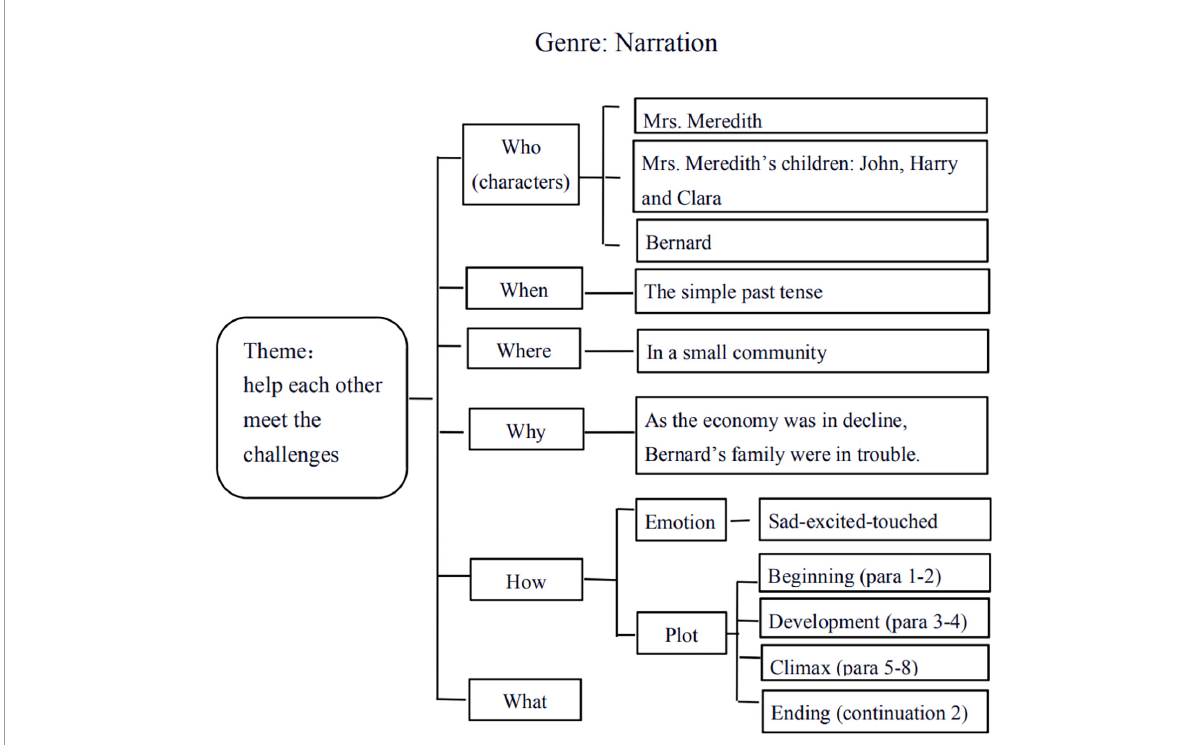
FIGURE2 The analytic framework for narrative texts (PowerPoint slide from Candy). Reproduced with